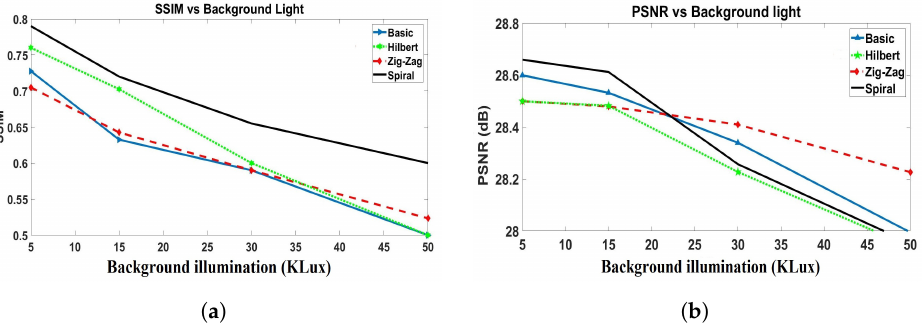
Figure 9. Image reconstruction using the NIR-SPI camera when placing the object 20 cm from the lens, using different scanning techniques in foggy conditions, and varying the background illumination between 5 and 50 kLux: ( a ) SSIM and ( b )